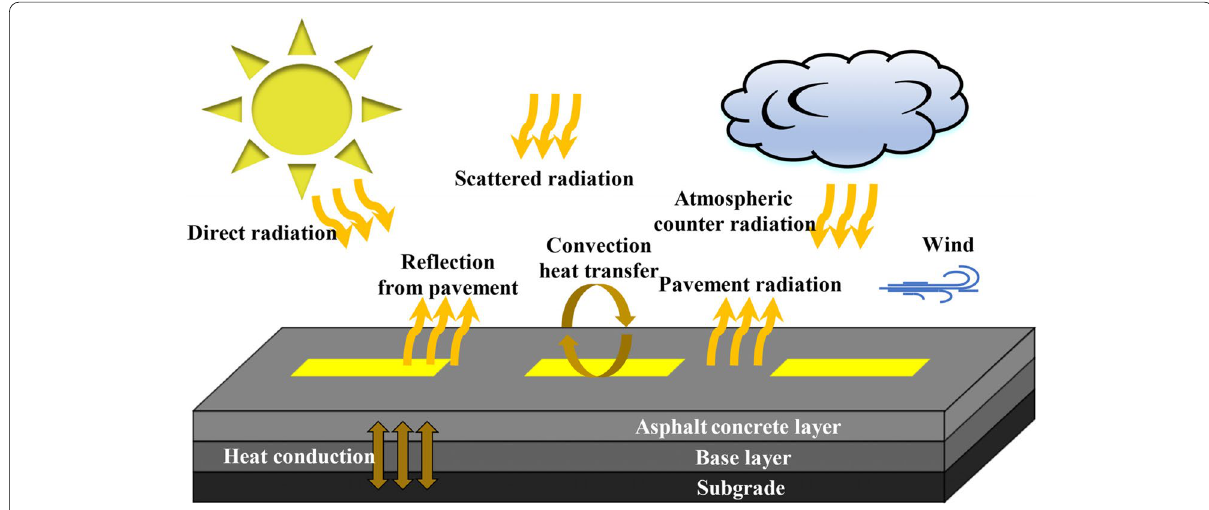
Fig. 2 The photo-thermal environment of asphalt